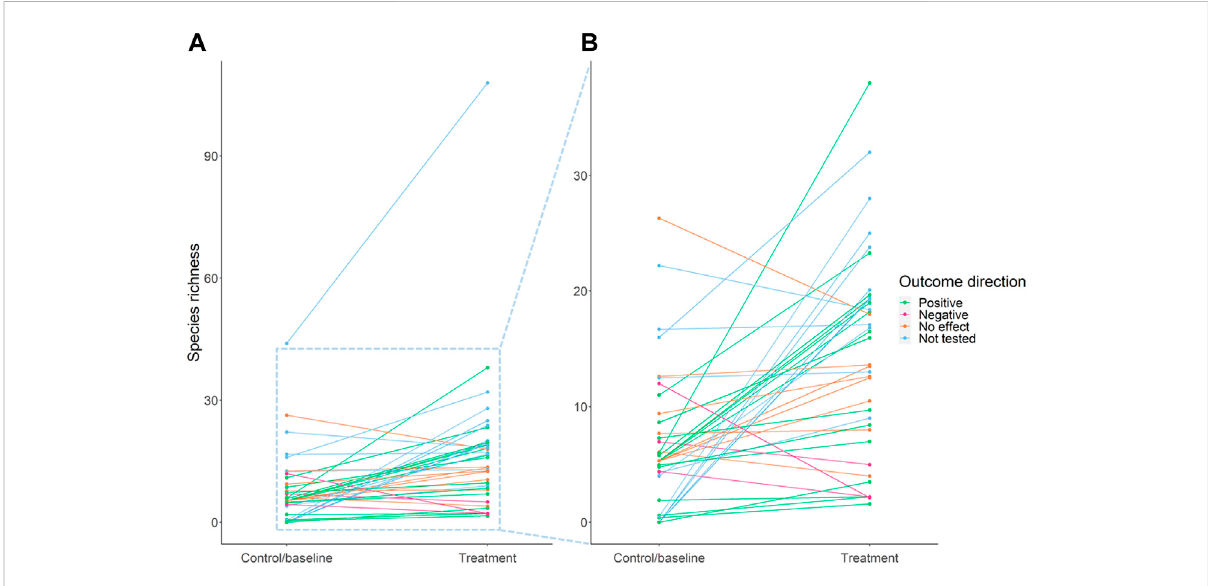
FIGURE 3 Change in species richness between control/baseline and treatment for 40 species richness outcomes, across 24 interventions. A larger scale view of the majority of the data from (A) is provided in (B) for clarity. Green lines represent statistically signi fi cant positive changes, pink lines are signi fi cant negative changes, orange lines are non-signi fi cant changes, and blue lines are changes which were not statistically tested. The change in species richness from Biel et al. (2017) is not included in the fi gure because the number of species was not given, only percentage changes in species